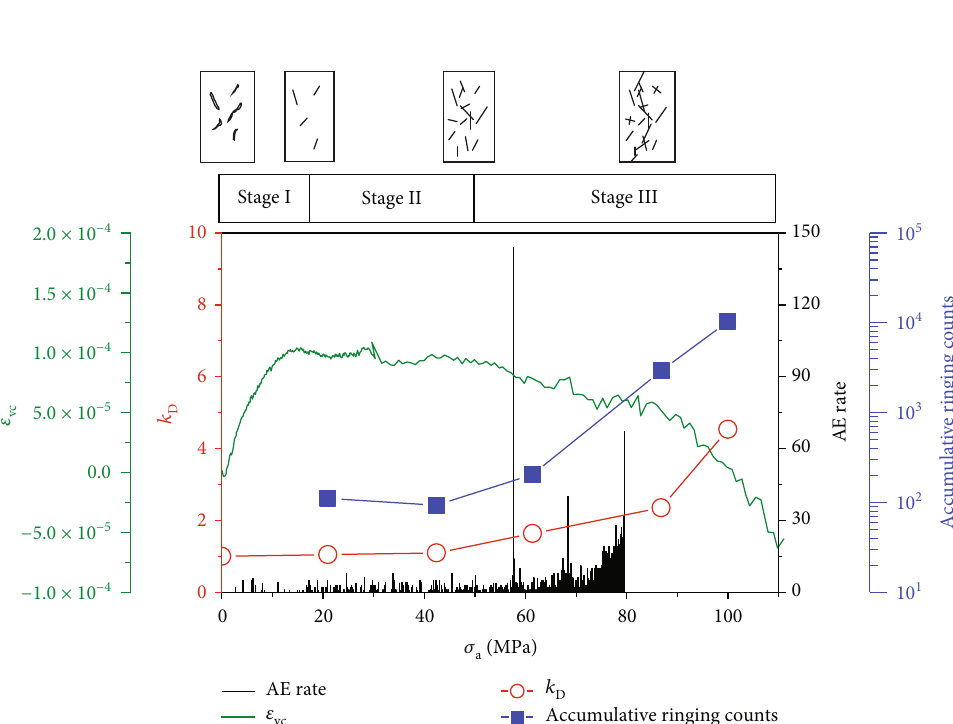
Figure 11: Calculated crack volumetric strain.